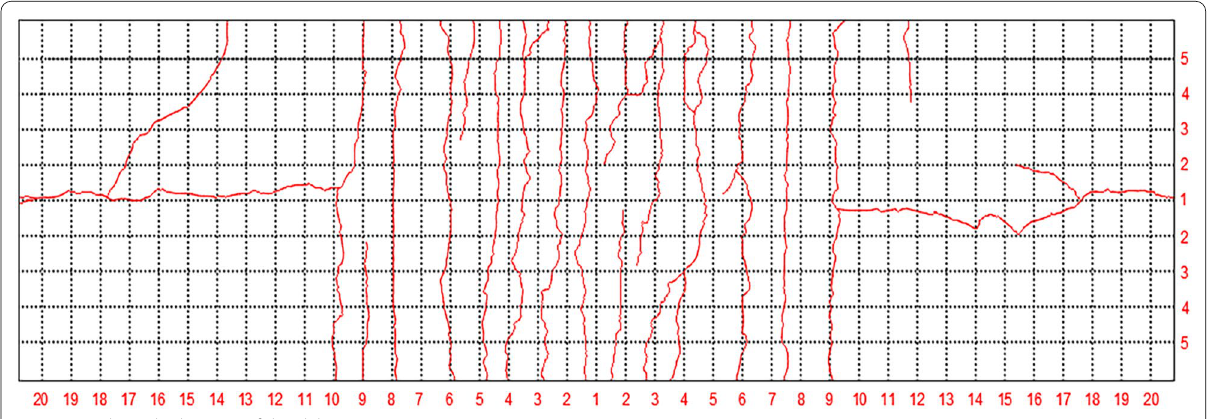
Fig. 7 Cracks at the bottom of the slab